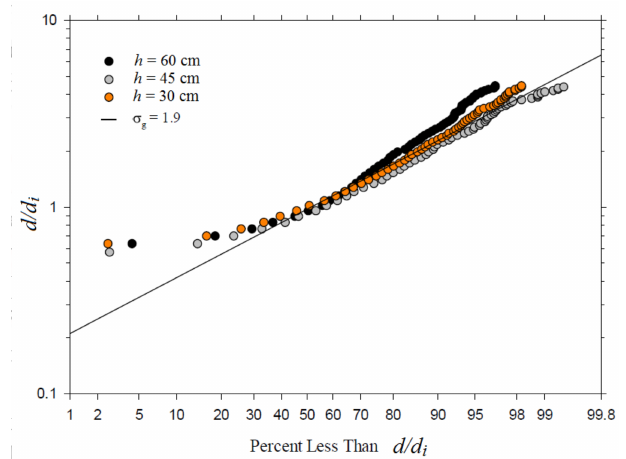
Figure 6. Distribution of the bubble diameter scaled with the injector tube diameter. Markers indicate the column height, which corresponds to locations shown in Figure 5. σ g is the geometrical standard deviation of d/d i . ( f = 12.5 Hz, A = 4.5 mm, U SG = 5.0 mm/s, P 0 = 1 atm).